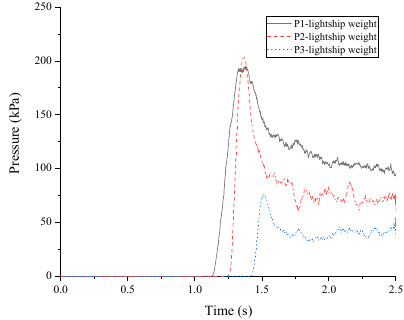
Figure 23. Pressure at P1, P2 and P3 in the case of lightship weight.